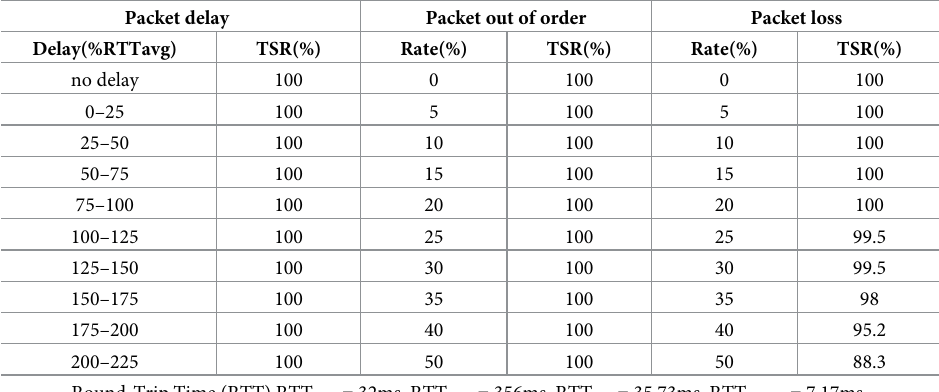
decreases gradually as the packet loss rate increases by more than 25%, even so, TSR is reason- able high when the packet loss rate increases to 50%. Therefore, the MLCCOSMS operates effectively in the actual network. Furthermore, we compared the IPDs of MLCCOSMS(32,4) with those of Cloak 5 (32,4) and TCP_trans(4) imple- mented between the same two hosts. Fig 6 shows that all the levels of delay interferences only slightly influence the IPDs of MLCCOSMS (32,4). Although the IPDs gradually increase with the increase in the out of order and packet loss interferences level, the curves basically match those of TCP_trans(4). Thus, the MLCCOSMS exhibits a strong camouflage capability in terms of the IPDs. Relatively, the IPDs of Cloak 5 (32,4) are larger than those of MLCCOSMS (32,4) and TCP_trans(4) under various situations, and sensitive to the interferences. Throughput. According to Eqs (1) and (2), the throughput of Cloak based on the packet- to-packet synchronization scheme and is: TH fine ack ¼ Cloak (bits/s) and that of the link-to-link and group-to-group synchronization schemes is: